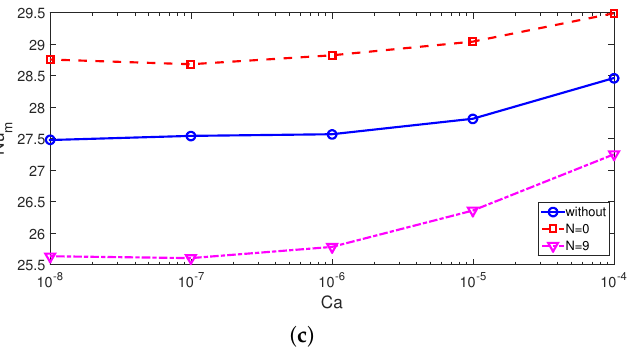
Figure 11. Effects of Ca number on the local ( a , b ) and average ( c ) Nu distributions for different cases of using PP (Re = 800, Ha = 15, Da = 10 − 2 ).